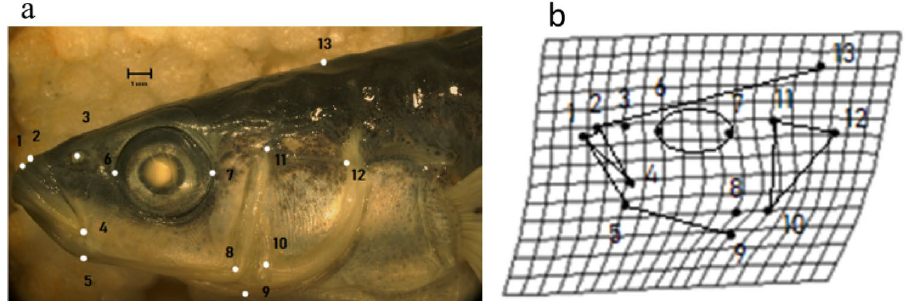
Figure 7. Analysis of stickleback head shape. Panel ( a ) shows an image of the left side of a female stickleback head sampled from the Black Creek Estuary site with anatomical landmarks (1–13) used for geometric morphometric analysis (see methods). Panel ( b ) is a thin-plate spline deformation grid which represents variation in the shape of the specimen in panel ( a ). The deformation grid is based on the Procrustes shape coordinates, generated from a generalized Procrustes analysis using the shape landmarks shows in panel ( a ) as described in the methods.